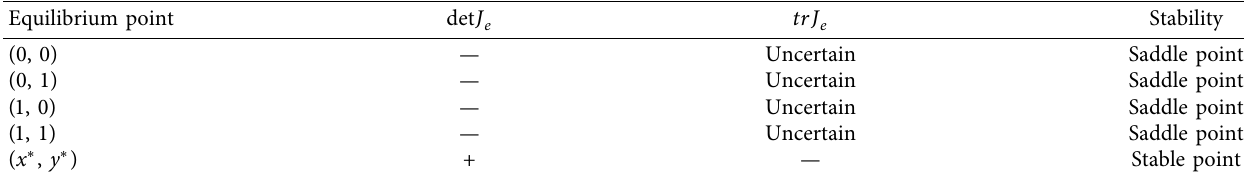
Table 4: Partial equilibrium